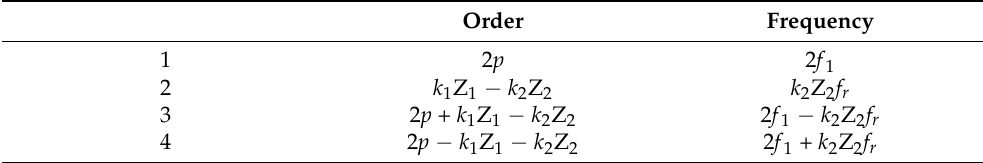
Table 1. Components of electromagnetic wave under normal operation.